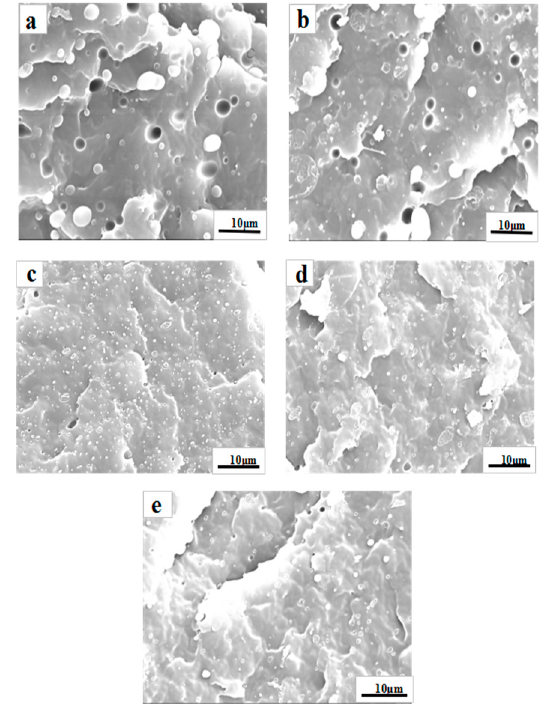
Figure 5. SEM images of the PP/PS blend ( a ), and that compatibilized using varied amounts of P1 (( b ) 1 wt.%, ( c ) 2 wt.%, ( d ) 3 wt.%, ( e ) 4 Table 2. Equal area circle diameter of the dispersed phase in the PP/PS blends compatibilized by using 2 wt% of the compatibilizer.